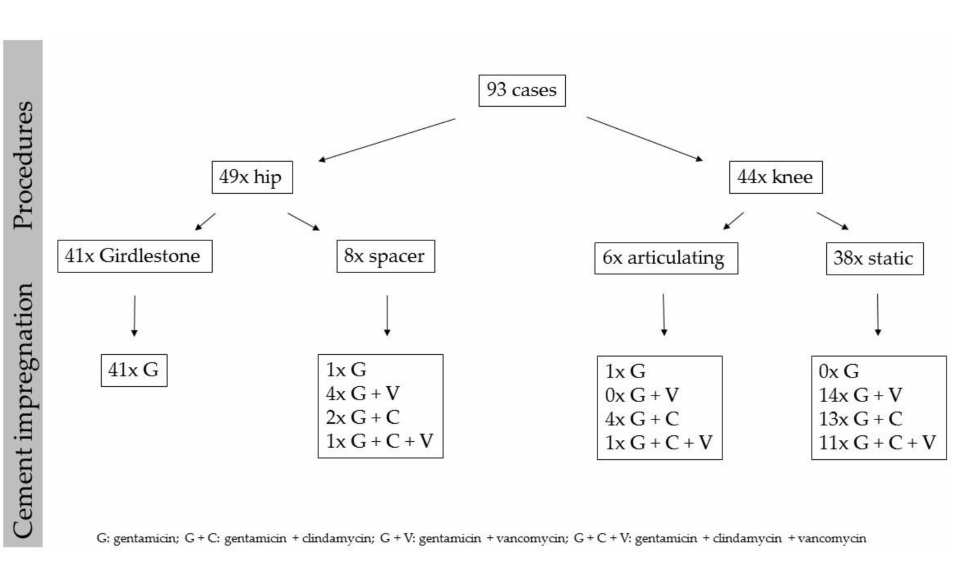
Figure 2. Data about the cement impregnation of spacers and beads at the site of 93 periprosthetic hip and knee joint